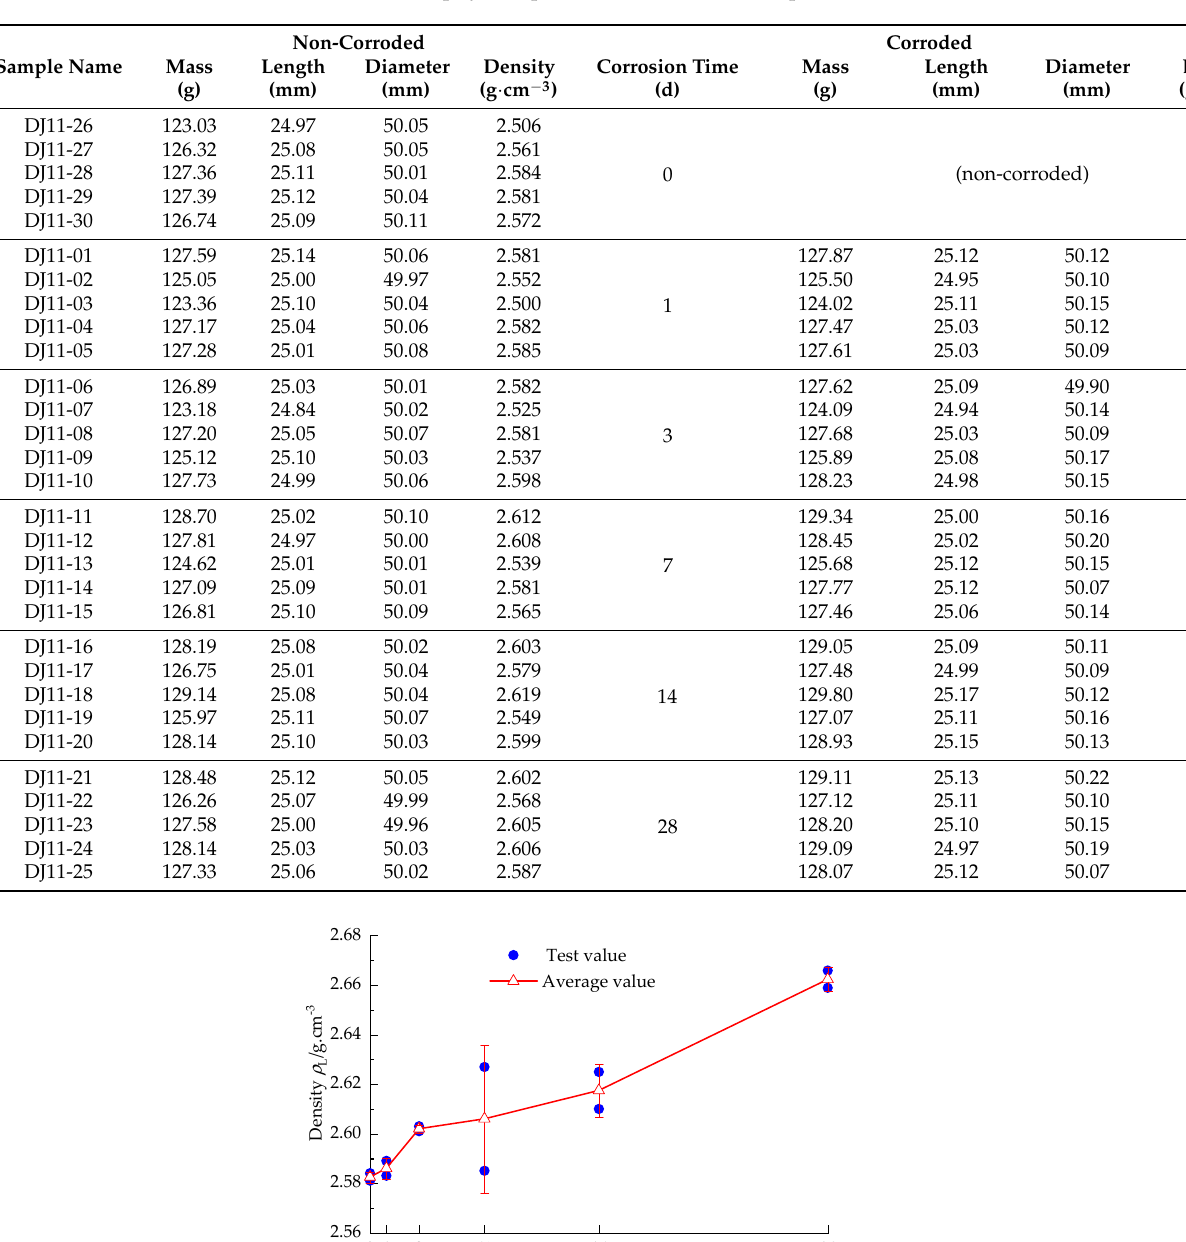
Table 1. Basic physical parameters of sandstone specimens.